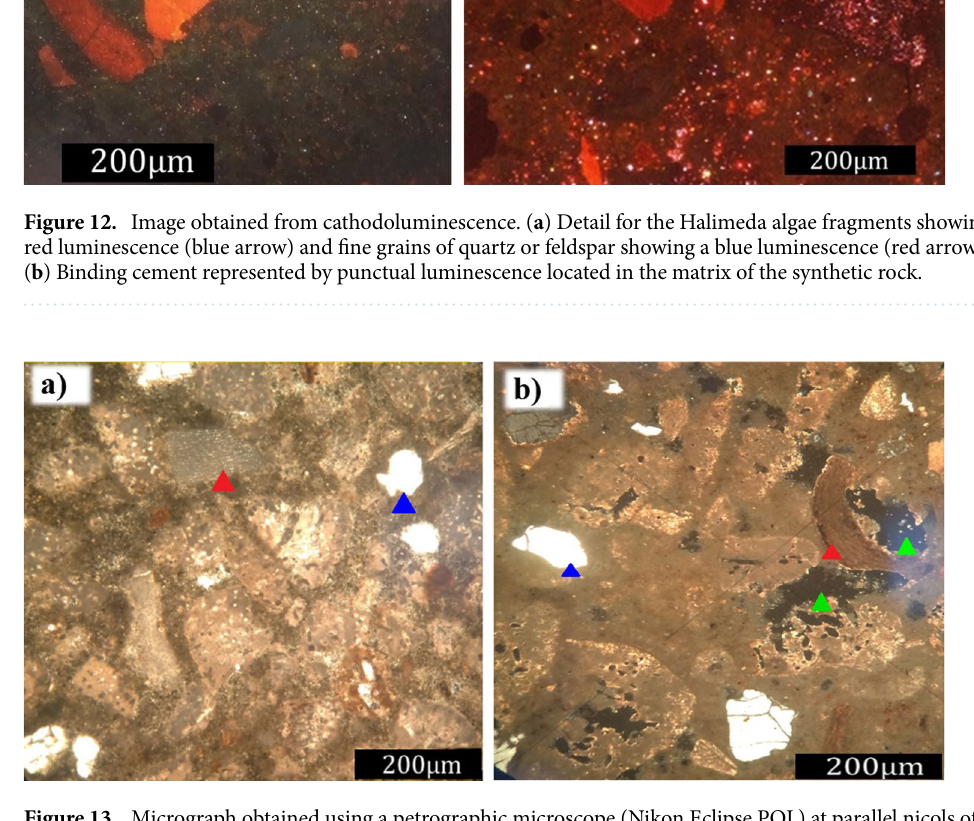
Figure 13. Micrograph obtained using a petrographic microscope (Nikon Eclipse POL) at parallel nicols of the samples ( a ) before and ( b ) after degradation, as well as calcium carbonate skeletal grains of a gastropod (red arrow—carbonate skeletal grain; green arrow—porosity; blue arrow—quartz